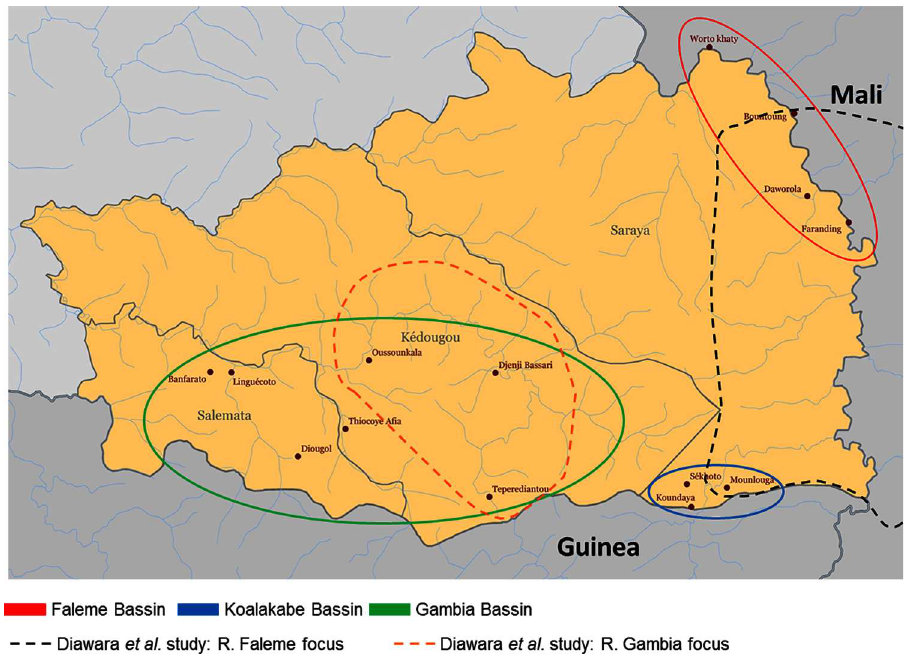
Fig 1. Villages included in the study by district and river and in comparison with [5] Diawara et al., 2009 study sites, Ke´dougou region, Senegal.